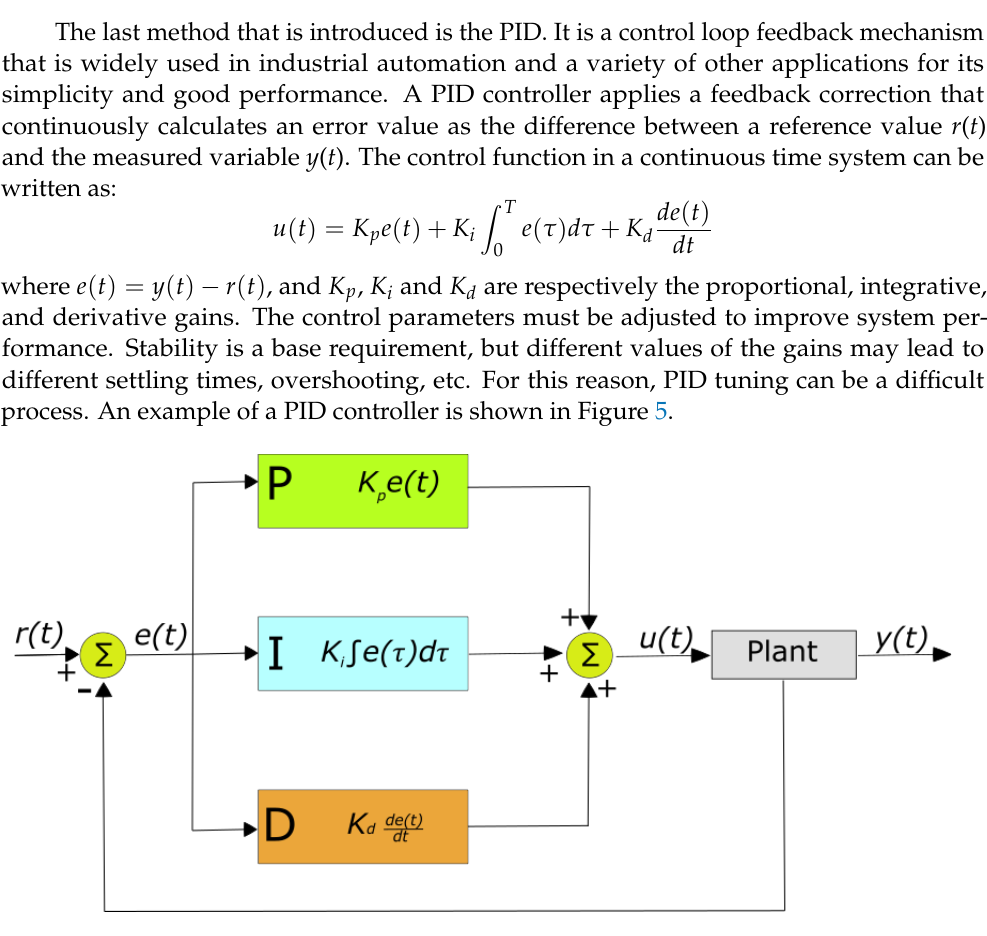
Figure 5 . PID controller design. Figure 5. PID controller